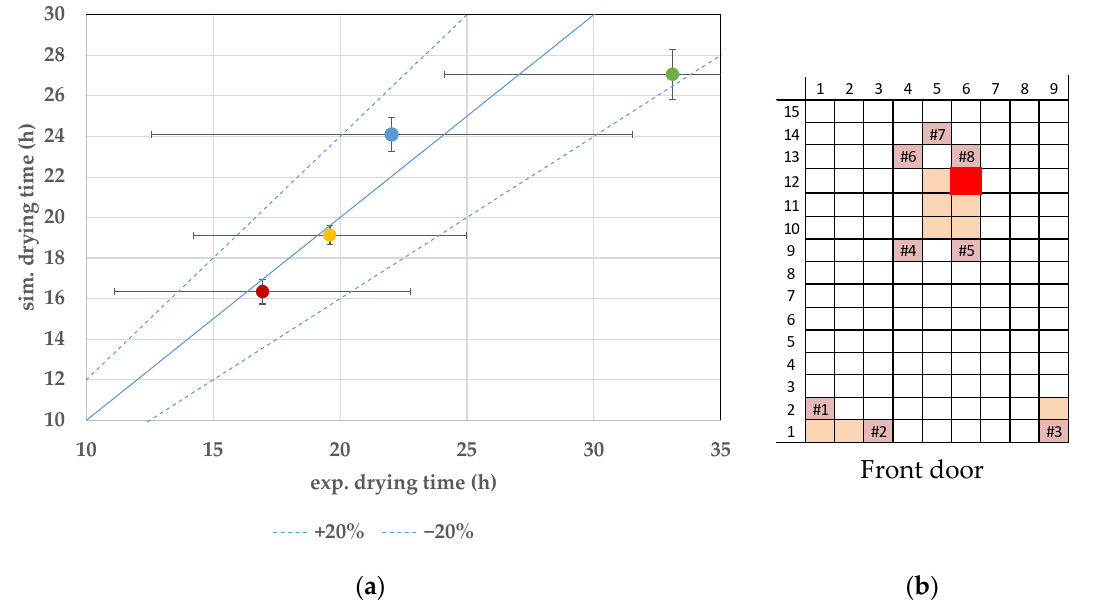
Figure 11. ( a ) Parity plot between the simulated and experimental primary drying endpoints for vial 12.6 (red: + − , yellow: ++, blue: CP, green: −− ). ( b ) Vial position.